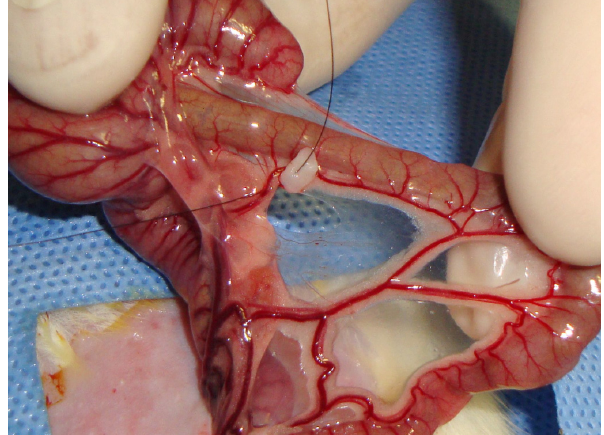
FIGURE 1 - Photomicrography showing construction of autotransplant according to Nogueira et al .